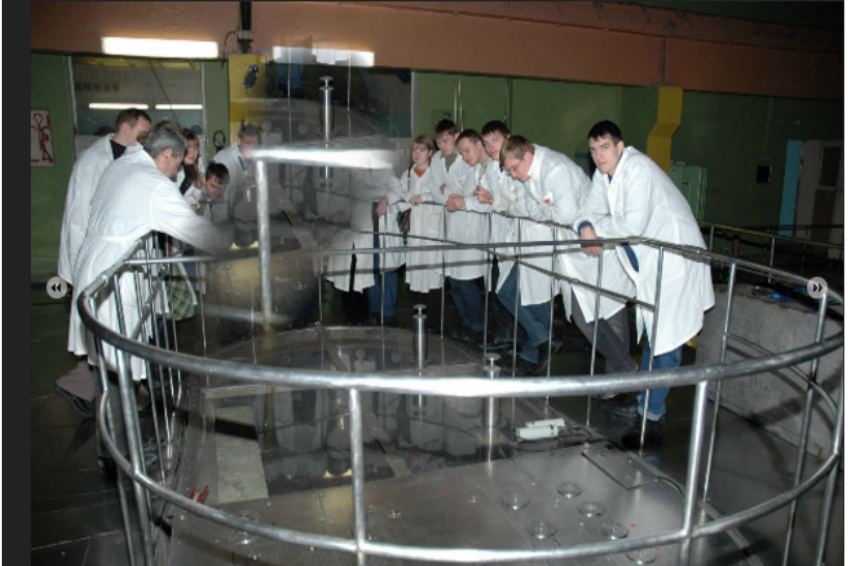
Fig. 2. A group of students at the IRT-T reactor